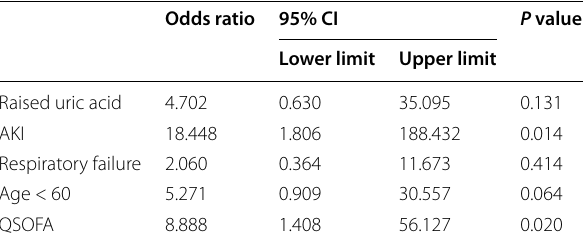
Table 3 Multivariable regression analysis for the predictors of death